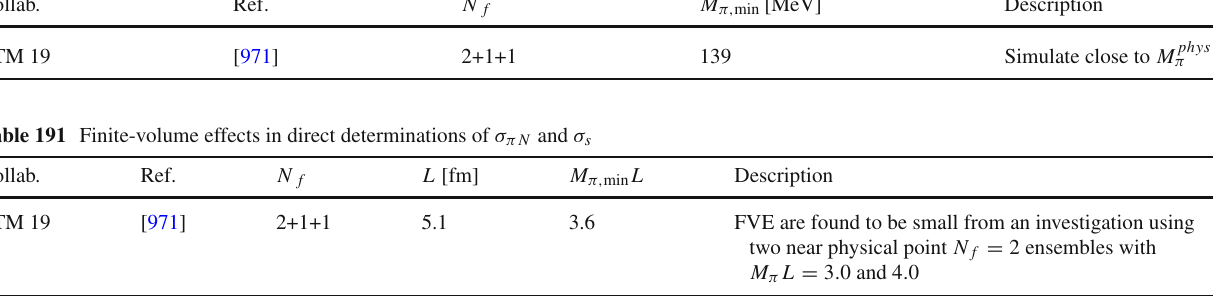
Table 190 Chiral extrapolation/minimum pion mass in direct determinations of σ π N and σ s Collab.